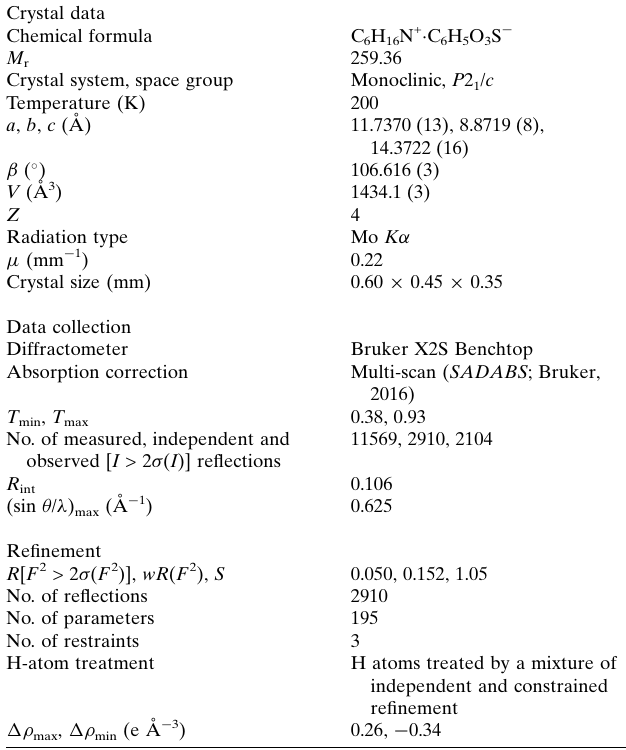
Table 2 Experimental details. Crystal data Chemical formula